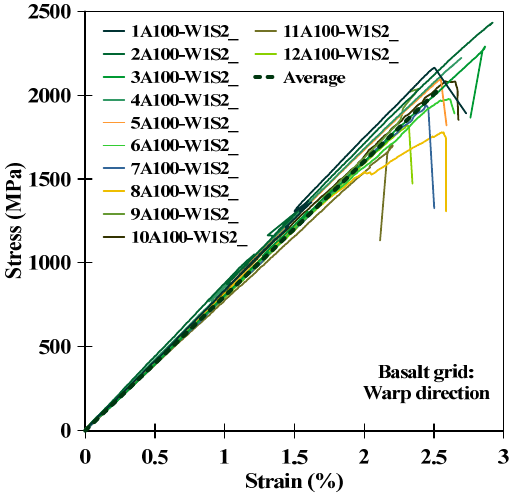
Figure 16. Stress–strain curves of basalt textile obtained using the video-extensometer.